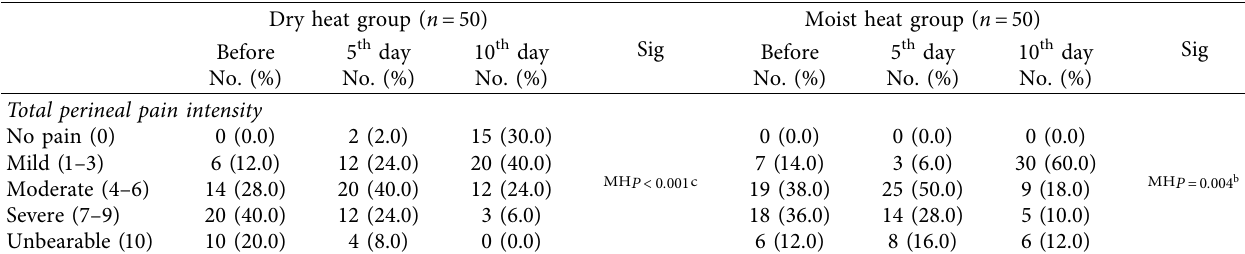
Table 2: Total scores of perineal pain intensity before and after the intervention of dry and moist heat